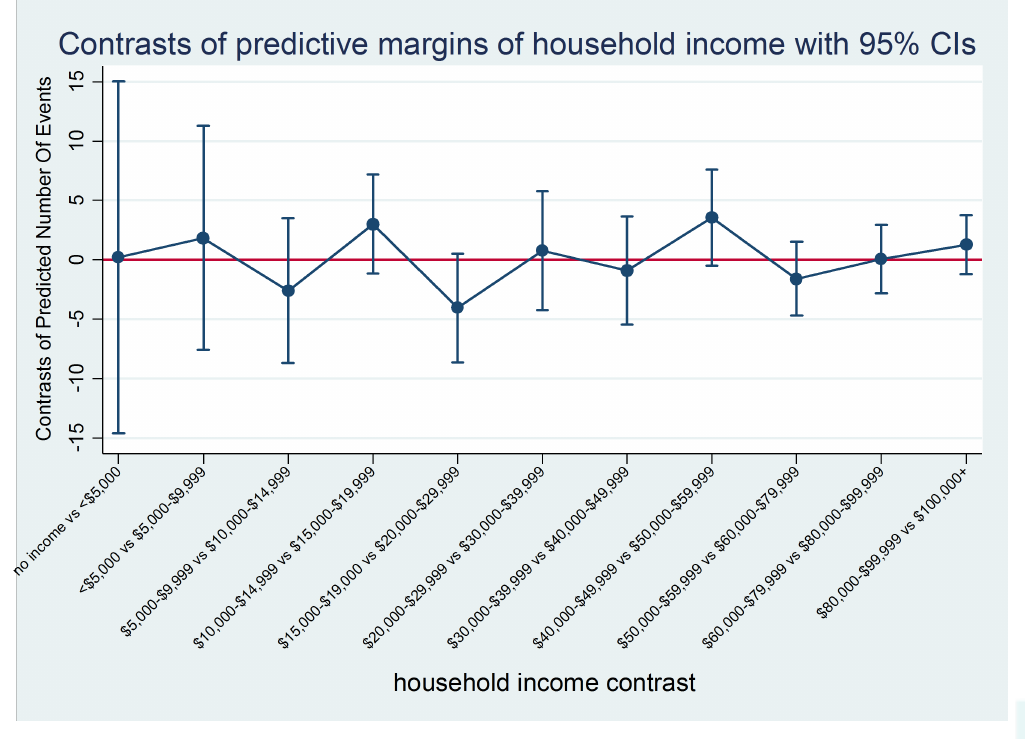
Data Source: Sample used complete case analysis from CCHS years